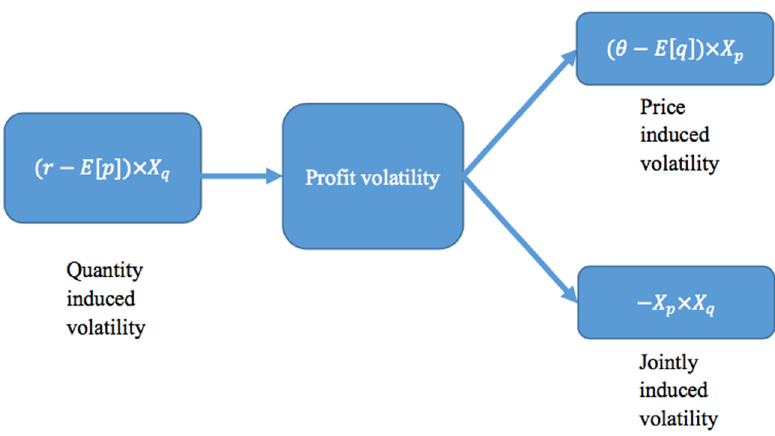
Figure 3. Profit volatility decomposition for model 4.